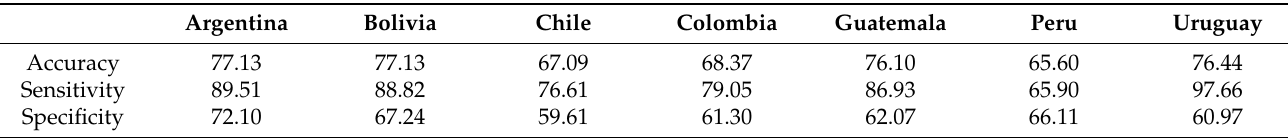
Table 7. LASSO confusion matrix, product innovation.